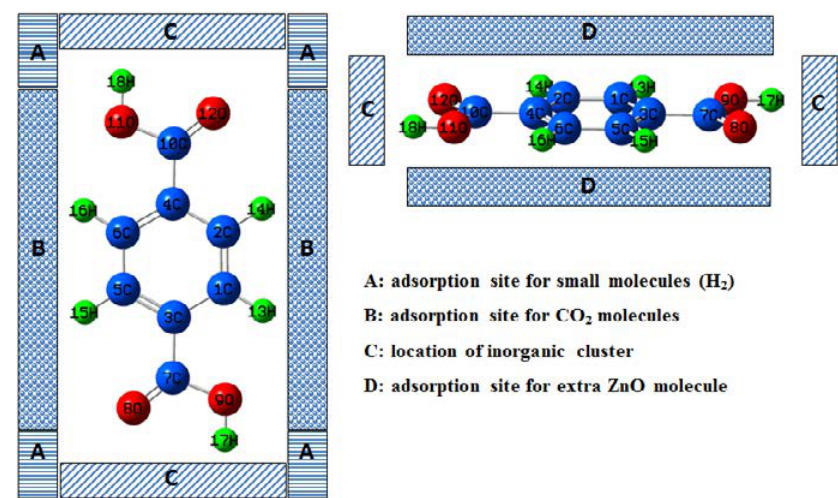
and H adsorption on top (or down) and side (left or right) 2 2 sections of ZnO-H 2